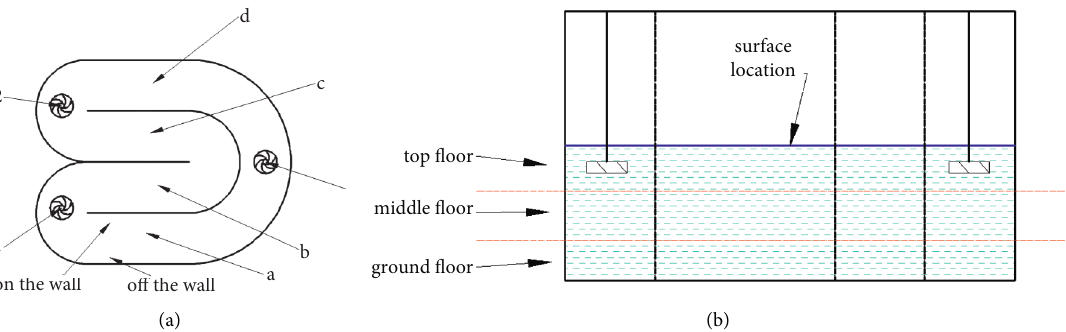
Figure 4: The name of the flow field and the flow channel.